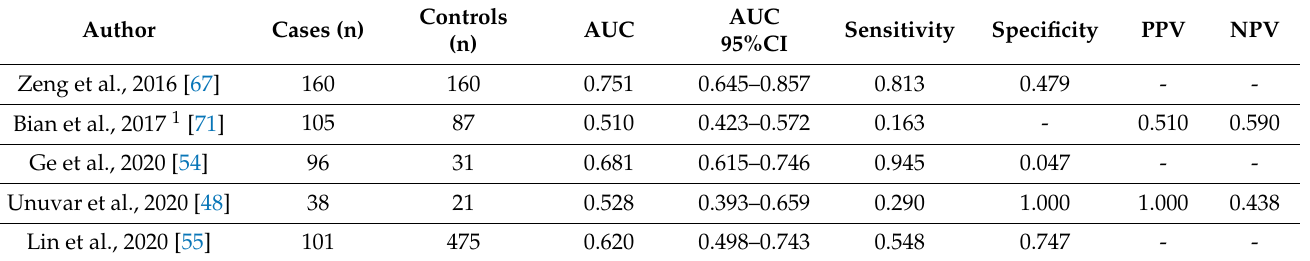
Table 7. Summary table of the performance of CA 19-9.